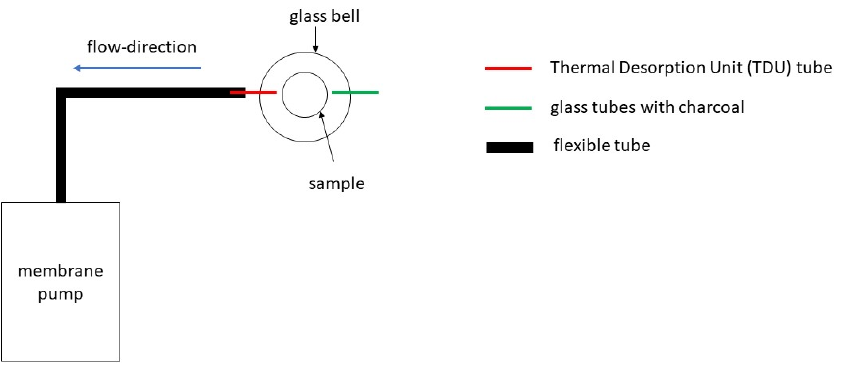
Figure 1. Setup for the sampling with assistance of the Scent Trap Kit.